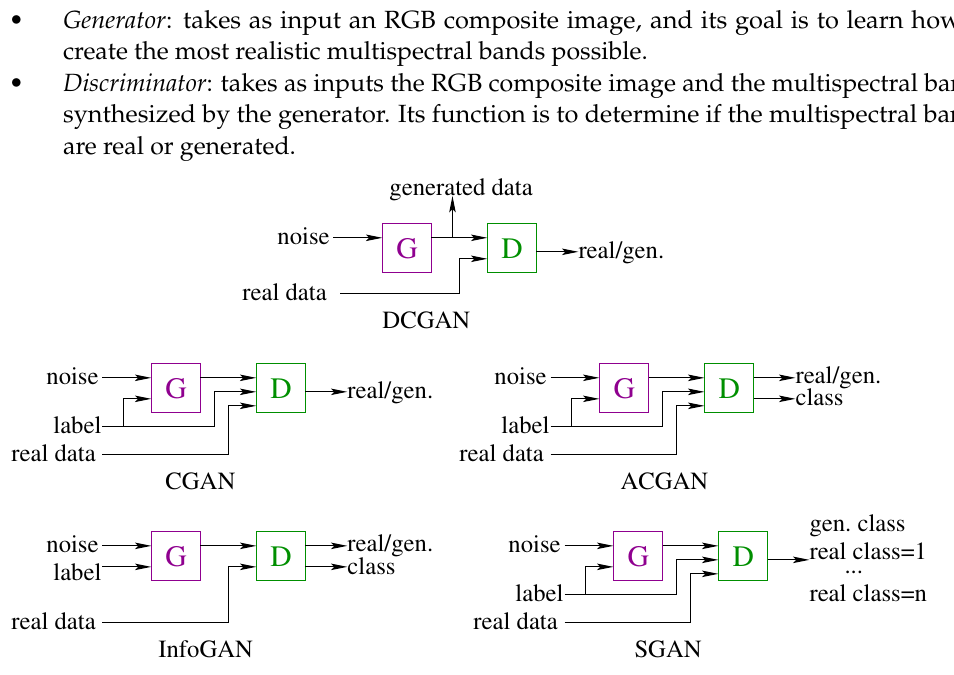
Figure 2. Different GAN architectures: DCGAN, CGAN, ACGAN, InfoGAN and